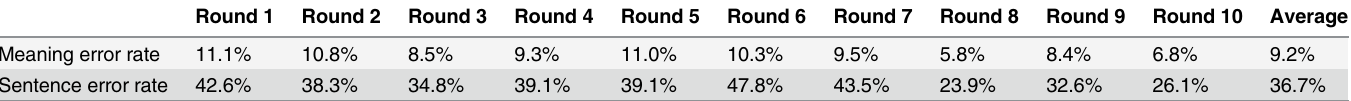
Table 9. Meaning errors and sentence errors on the ten rounds of the ten-fold cross validation. Meaning error is the percentage of incorrect thematic role assignment. Sentence error is the percentage of sentences in which there is at least one wrong thematic role